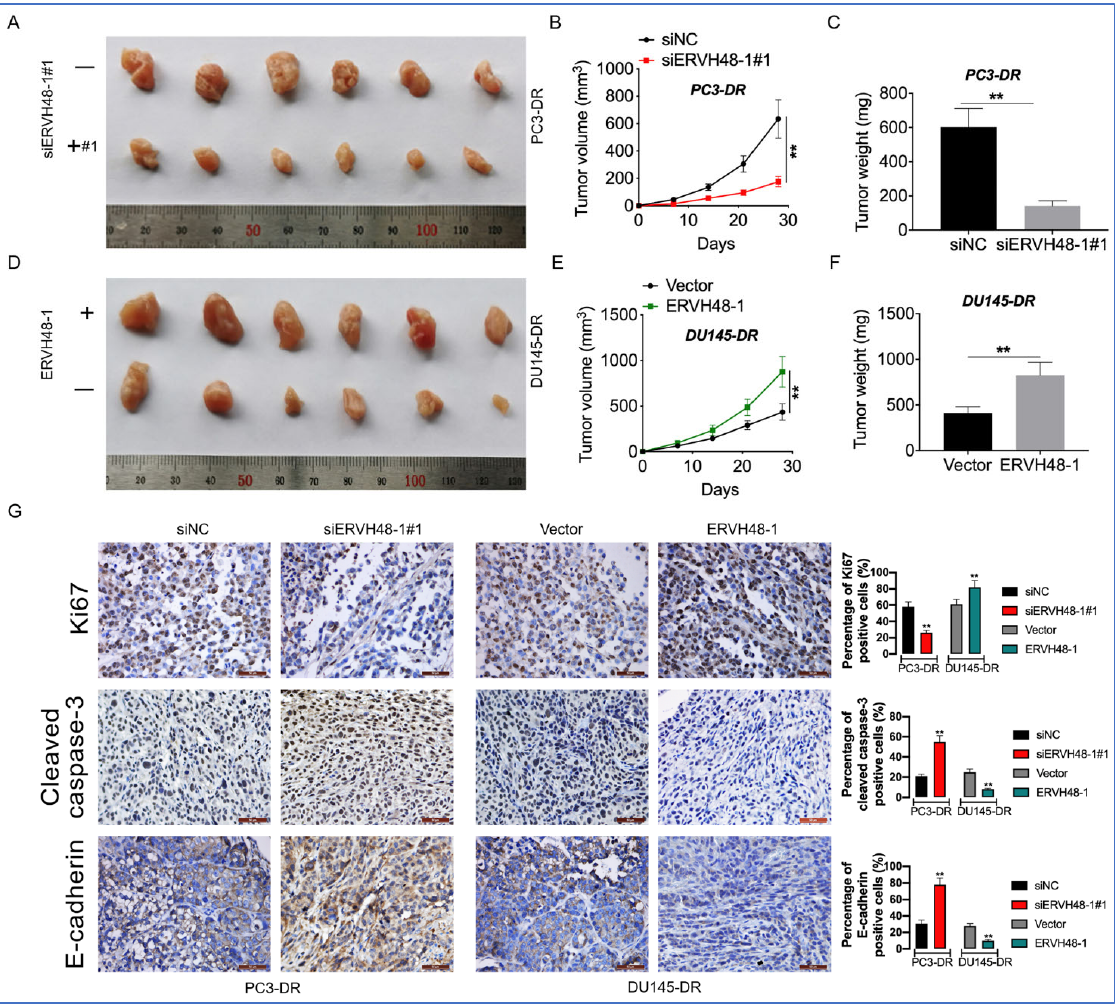
Figure 7. ERVH48 ‐ 1 has an impact on the oncogenicity of Dox ‐ resistant PCa cells in vivo. ( A ) Sub ‐ Figure 7. ERVH48-1 has an impact on the oncogenicity of Dox-resistant PCa cells in vivo. cutaneous injections of PC3 ‐ DR cells transfected with siRNA against ERVH48 ‐ 1 were given to null ( A ) Subcutaneous injections of PC3-DR cells transfected with siRNA against ERVH48-1 were given to mice. ( B , C , E , F ) Tumor weights and volumes. ( D ) Nude mice were subcutaneously injected with null mice. ( B , C , E , F ) Tumor weights and volumes. ( D ) Nude mice were subcutaneously injected with DU145 ‐ DR cells that had been transfected with vectors expressing ERVH48 ‐ 1. ( G ) IHC analysis of DU145-DR cells that had been transfected with vectors expressing ERVH48-1. ( G ) IHC analysis of Ki67 expression, cleaved caspase ‐ 3 expression, and E ‐ cadherin expression. ** p < 0.01. All experi ‐ ments were repeated three times. Ki67 expression, cleaved caspase-3 expression, and E-cadherin expression. ** p < 0.01. All experiments were repeated three In order for the ERVH48 ‐ 1 ‐ regulated posttranscriptional pathway to operate appro ‐ priately in PC3 ‐ DR and DU145 ‐ DR cells, the ERVH48 ‐ 1 protein must be localized in the 4784 increased noticeably as a direct result of the suppression of ERVH48 ‐ 1. Increased miR ‐ 4784 expression can be achieved in PC3 ‐ DR and DU145 ‐ DR cells through transfection with an miR ‐ 4784 mimic (Figure 8C,D). Using StarBase, we were also able to anticipate the presence of binding sites for ERVH48 ‐ 1 and miR ‐ 4784 (Figure 8E). Using a dual ‐ lucif ‐ erase reporter assay, it was found that miR4784 mimics and strongly inhibits luciferase activity in cells that were transfected with ERVH48 ‐ 1WT (Figure 8F). Additional Ago2 ‐ RIP investigations not only demonstrated that miR ‐ 4784 and ERVH48 ‐ 1 are enriched in the Ago2 ‐ immunoprecipitated complex but they also demonstrated that direct binding exists between miR ‐ 4784 and ERVH48 ‐ 1 (Figure 8G). It would appear from the facts at